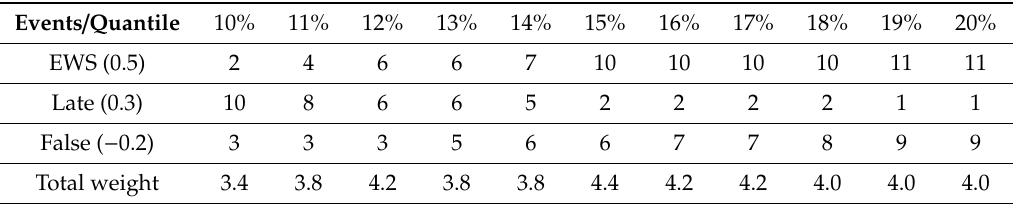
Table 4. Results of EWS from the water level data for di ff erent values of the quantile with their respective